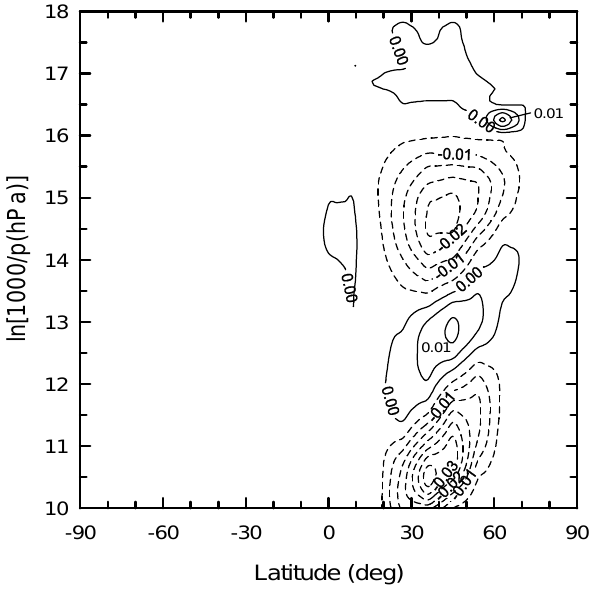
Fig. 14. As in Fig. 10, but for the 2-day wave and only for 1